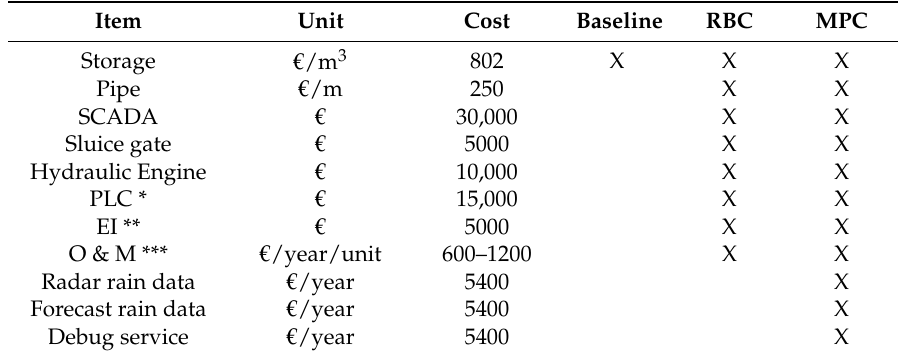
Table A1. Unit utility cost descriptions for all scenarios tested. A cross (X) means that the item is included in the given scenario.